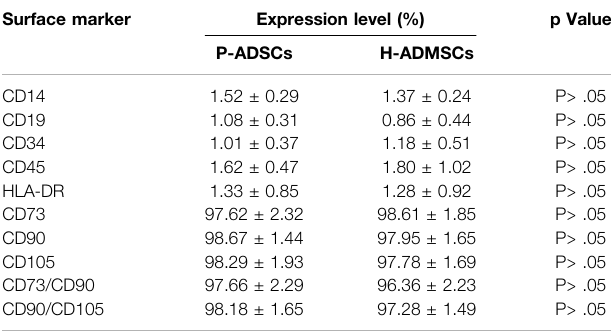
TABLE 1 | Surface marker expression levels of P-ADSCs and H-ADSCs at passage fi ve in hPL. Surface